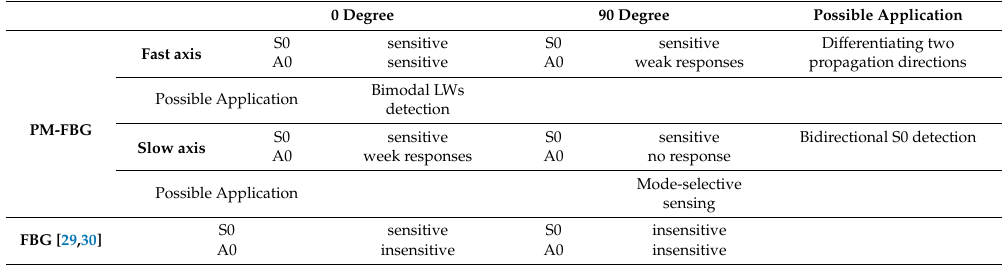
Table 1. Bimodal and bidirectional Lamb waves detection of Polarization-maintaining Fiber Bragg grating and corresponding characteristics of fiber Bragg